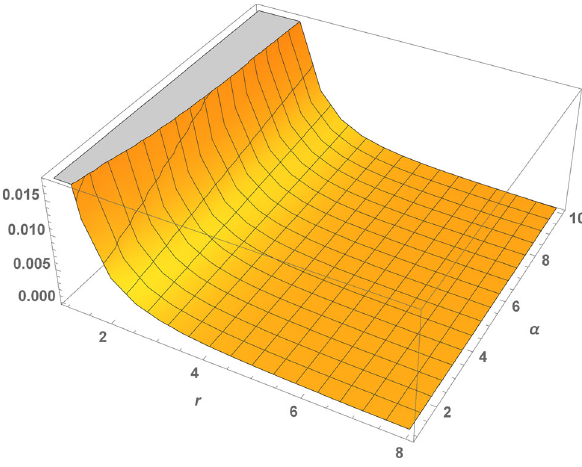
Fig. 3 Variation of energy density for α = 5 and different λ